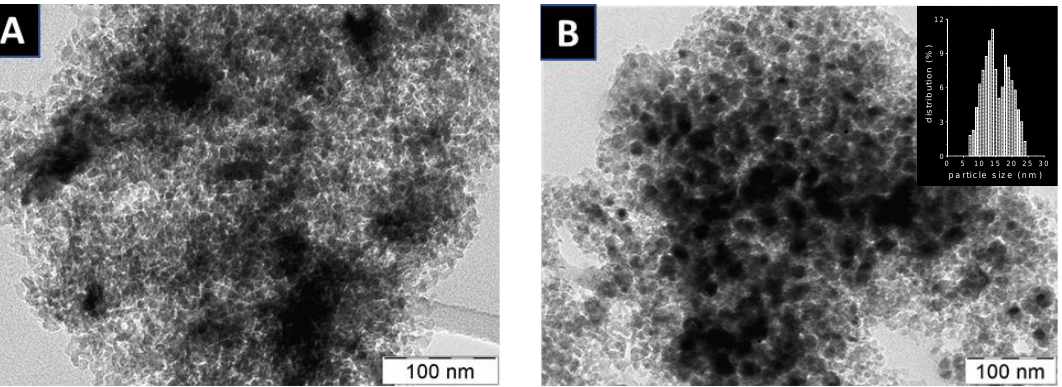
Figure 5. TEM image of the Cu(5)Fe(5)-Si sample: ( A ) calcined at 500 °C in air; ( B ) reduced at 400 °C under H 2 atmosphere.